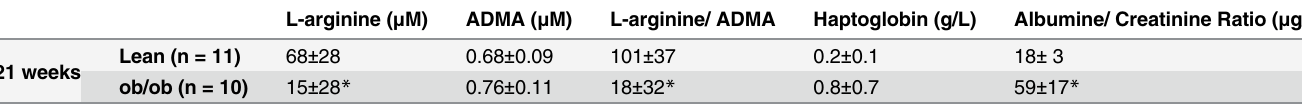
Table 3. Plasma and urine biomarkers at 21 weeks of age in lean controls and leptin-deficient mice.